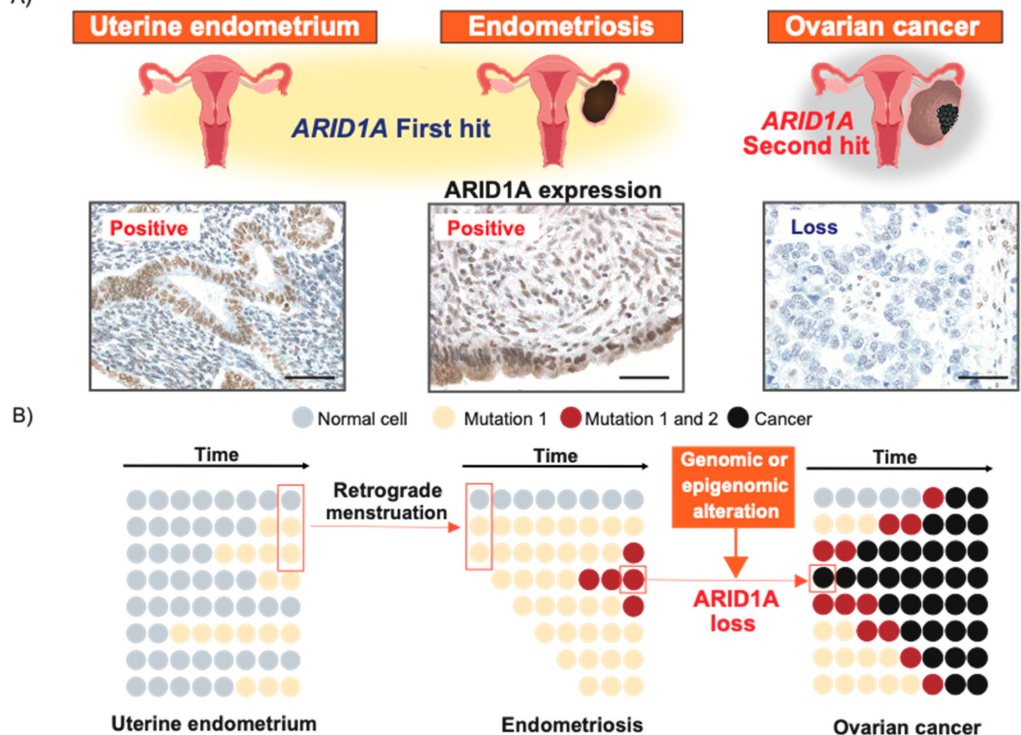
Figure 2. Molecular mechanism of EAOC development from uterine endometrium via endometriosis focused on ARID1A . ( A ) The second hit model of ARID1A in EAOC development from uterine endometrium via endometriosis. ( B ) The model that explain the process of ARID1A mutant cell progression for the development of